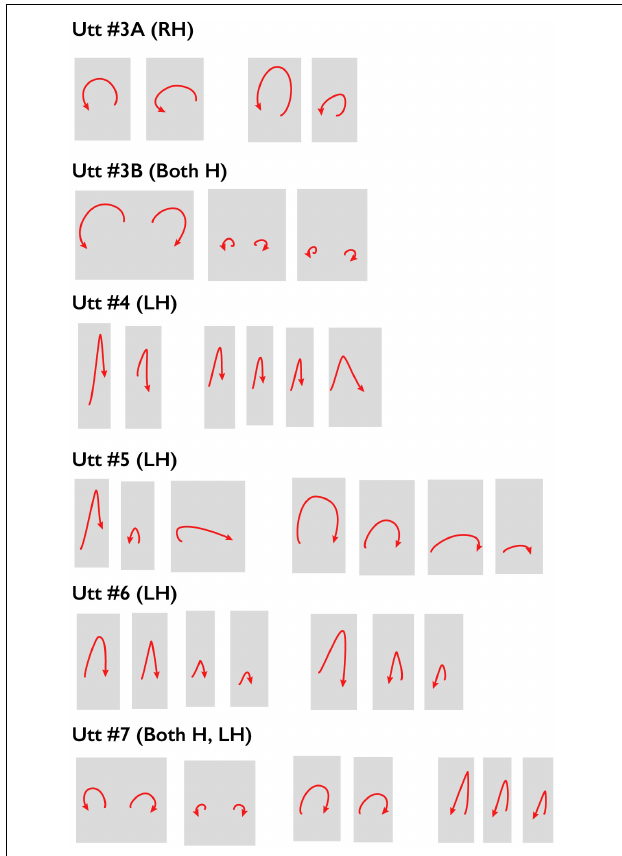
FIGURE 4 | Gesture sketches for sequences of gestures that align with higher-level prosodic constituents (here called Utterances), as determined by Extended Rapid Prosodic Labelling, in the first 2 min 15 s of the London sample. Utt 1 contained no gestures, and during Utt 2 the speaker was mostly occluded by a graphic. Wider spaces indicate boundaries between successive Perceived Gesture Groups. See text for further